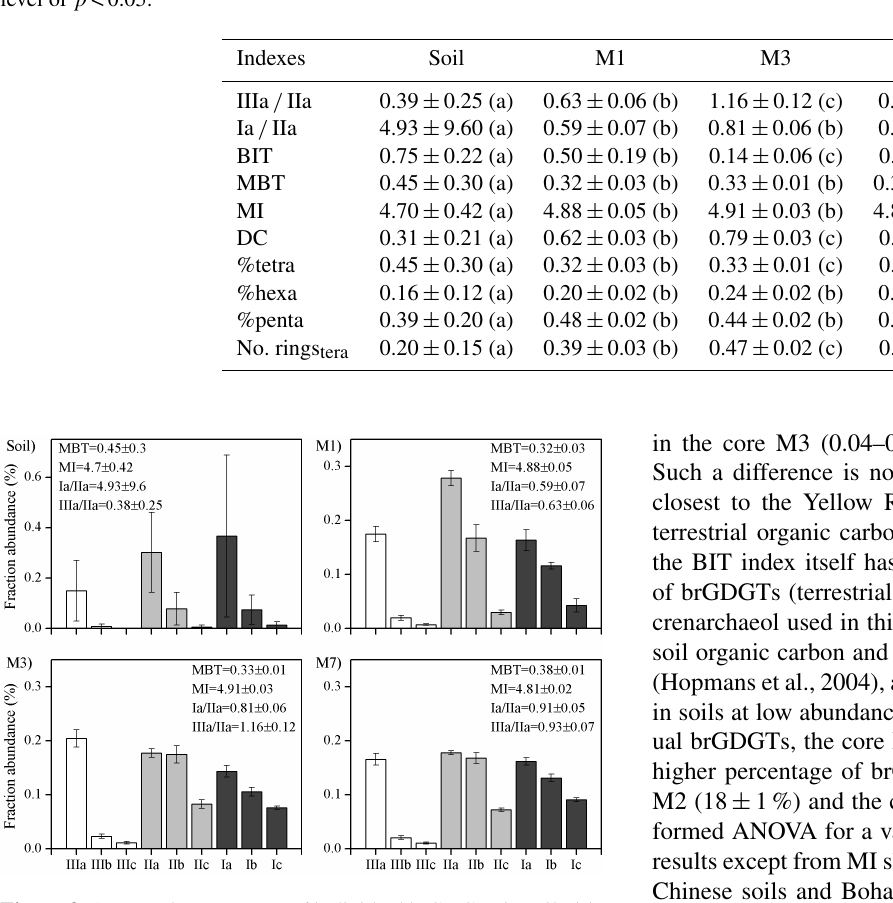
Figure 3. Averaged percentages of individual brGDGTs in soils (a) , core M1 (b) , M3 (c) and M7 (d) . The soil data are from Yang et al.